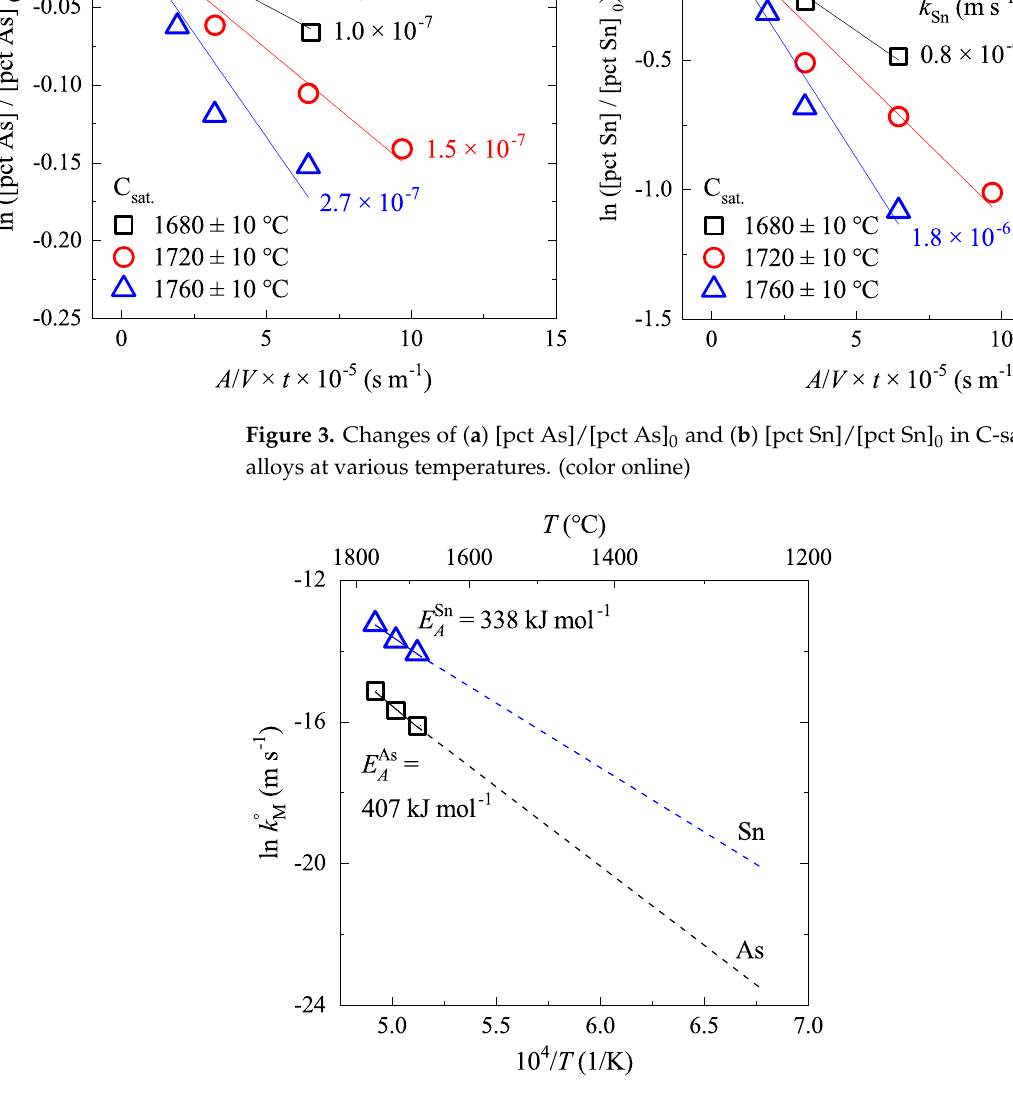
Figure 4. Arrhenius plot of the apparent rate constants of As and Sn. Dashed lines are the extrapo- lated to the lower temperature (near steelmaking temperature) from the temperature of the present experiment